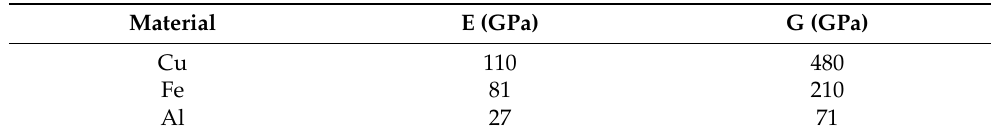
Table 2. The mechanical characteristics of selected